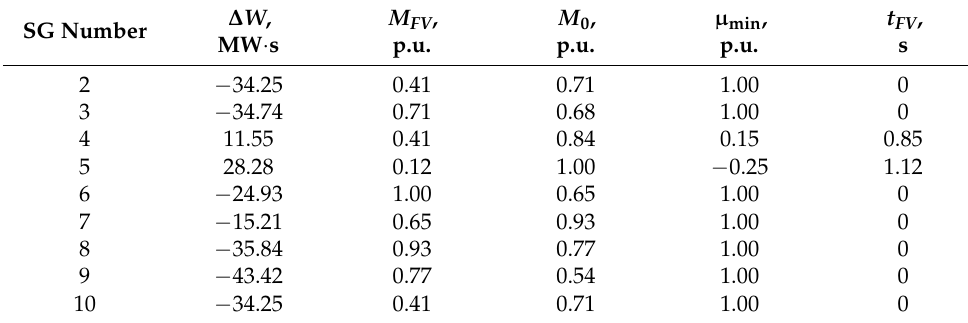
Table 4. Results of TFV control synthesis.